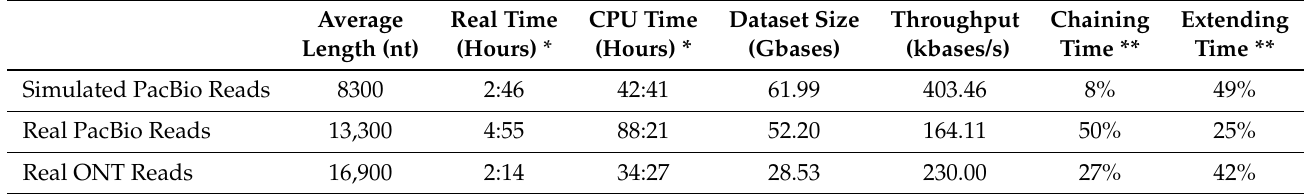
Table 3. Minimap2’s throughput and bottlenecks running on long-read datasets.